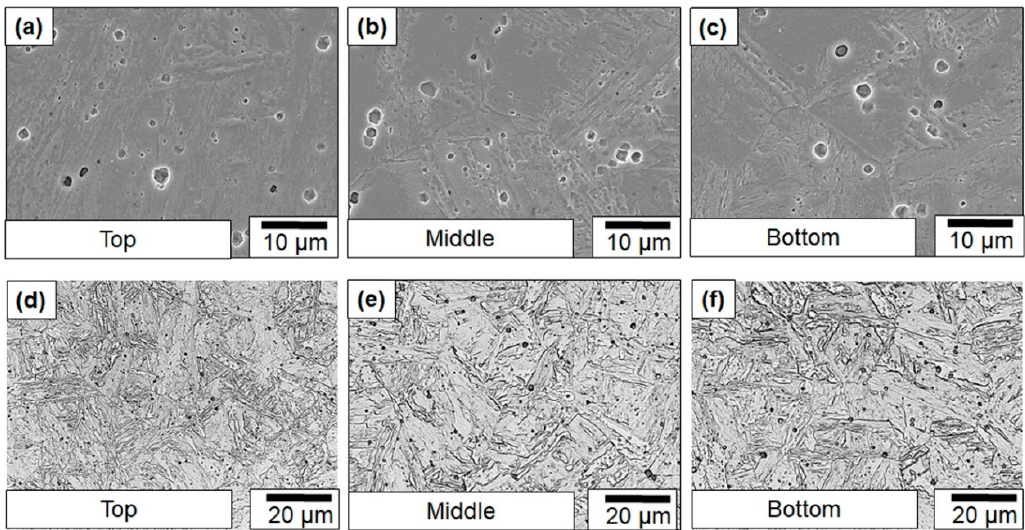
Figure 11. ( a – c ) Scanning electron and ( d – f ) optical micrographs of austenitized samples sectioned from the ( a , d ) top, ( b , e ) middle, and ( c , f ) bottom of the wall.